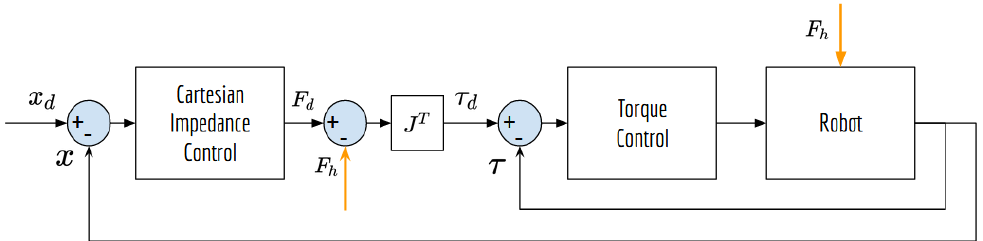
Figure 3. Admittance control (position-based impedance control).